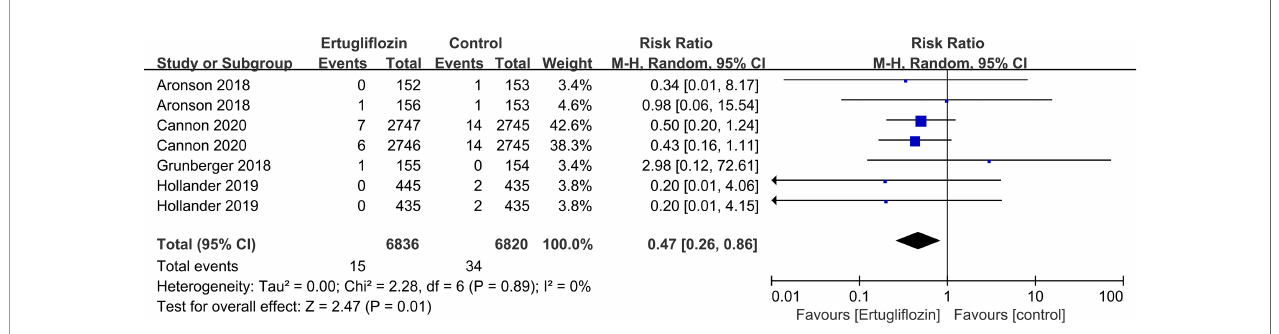
FIGURE 6 | Effect of ertugli fl ozin on incidences of retinal disease compared with control in T2DM